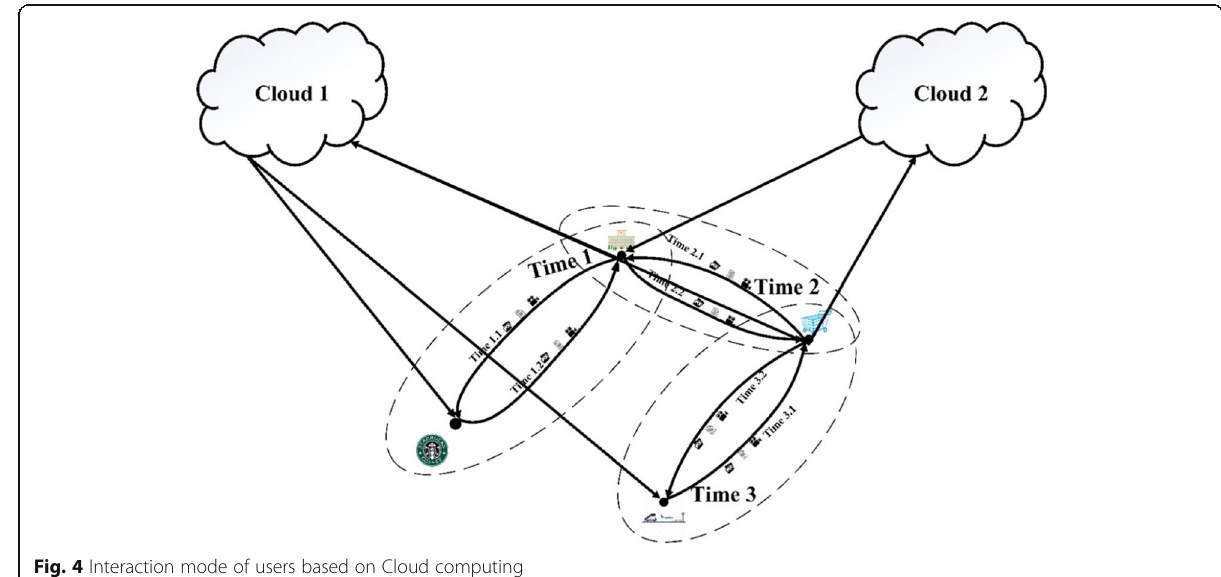
Fig. 4 Interaction mode of users based on Cloud